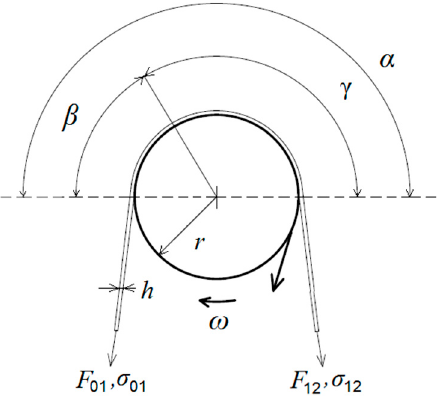
Figure 1. Analysis of the contact surface between roll and strip in steady state.